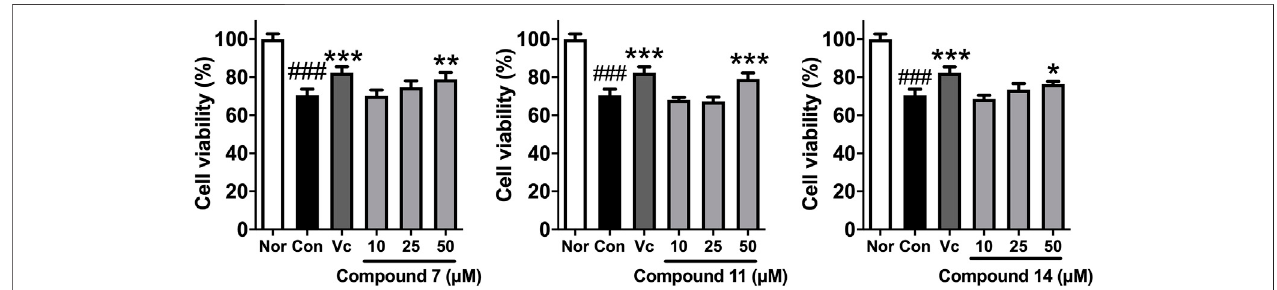
FIGURE8| Theeffectsofcompounds 7 , 11 ,and 14 atconcentrationof10,25,50 μ MonthecellviabilityofHaCaTcellsinducedbyUVB.Nor:normalgroup;Con: UVB-induced group; Vitamin C (Vc). Values represent the mean ± SEM of six determinations ( ### p < 0.001 vs. Nor; *** p < 0.001, ** p < 0.01, and * p < 0.05 vs. Con).